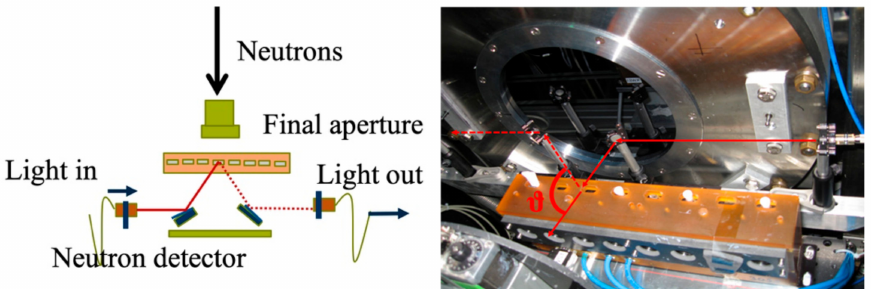
Figure 8. Left : Schematic view of the setup for simultaneous DLS and SANS analysis of samples using the KWS-2. Right : view of the setup on the sample stage of the neutron SANS diffractometer, between the sample aperture of the collimation system and the entrance window of the evacuated detector tank. Light beam trajectories to and from the sample are indicated in red. The sample cuvettes are placed in the locations of a Peltier-based multi-position variable temperature holder (Quantum Northwest Inc., Liberty Lake, WA, USA) that can move each sample in neutron/light beams in a controlled